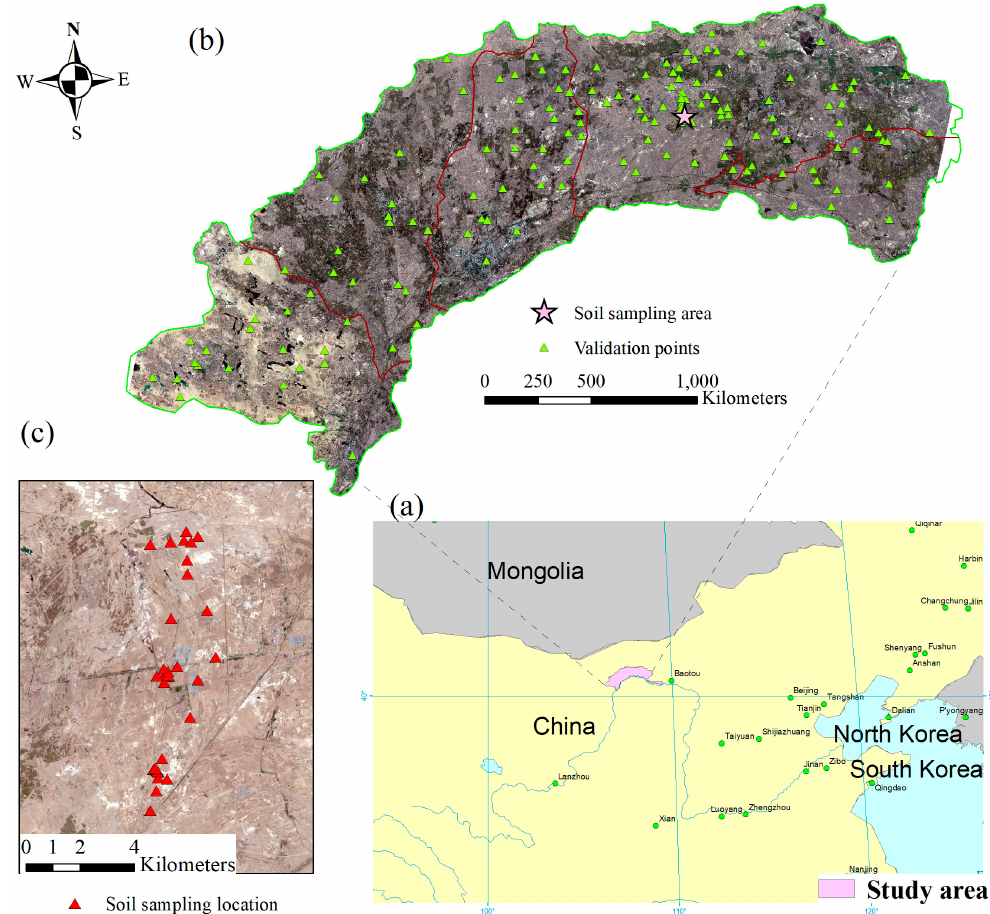
Figure 1. Overview of the Hetao Irrigation District: ( a ) geographic location, ( b ) land surface of the study area depicted by Landsat 8 OLI imagery captured on 30 October 2019, and ( c ) soil sampling locations for EC measurement.